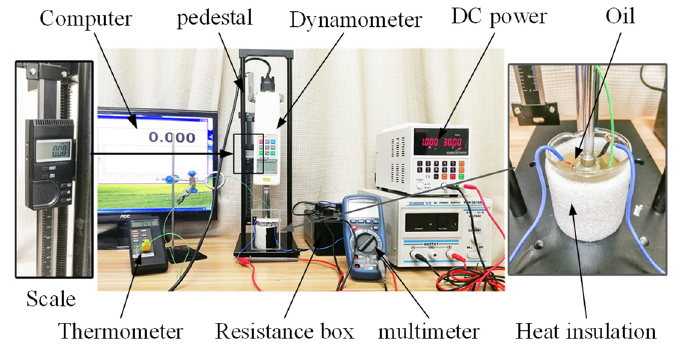
Figure 7. SMA spring thermal driving performance test.